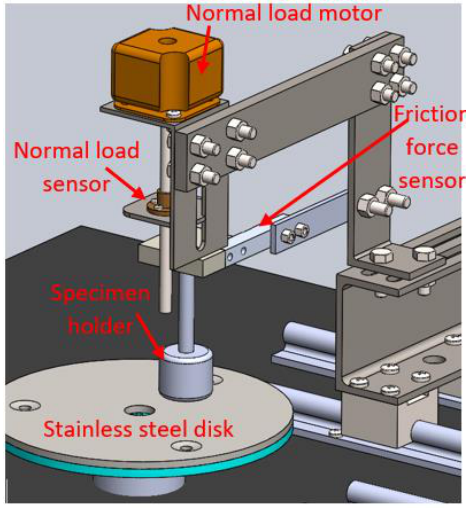
Figure 4. Tribometer schematic.